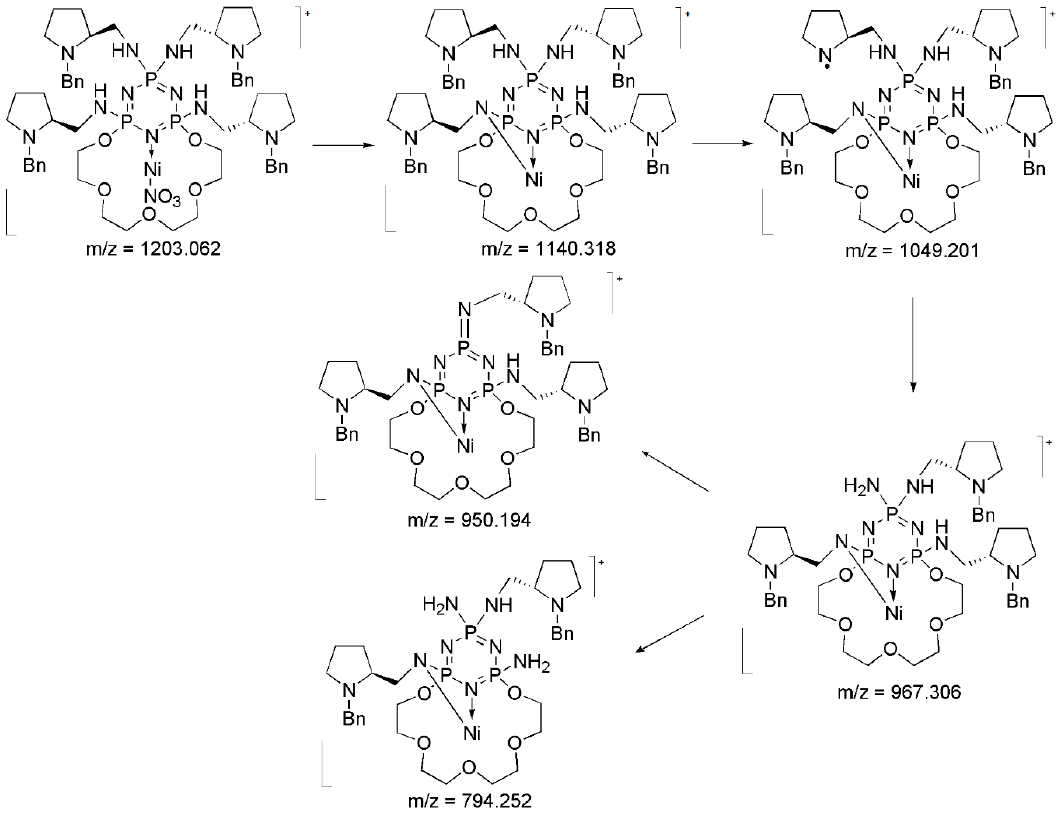
Figure 8. The ESI-mass spectrum of the complex obtained by mixing acetonitrile solutions of L with Ni(NO 3 ) 2 and the ESI-MS / MS 2 spectrum of the [Ni (II) L + NO 3 ] + complex form (inset).